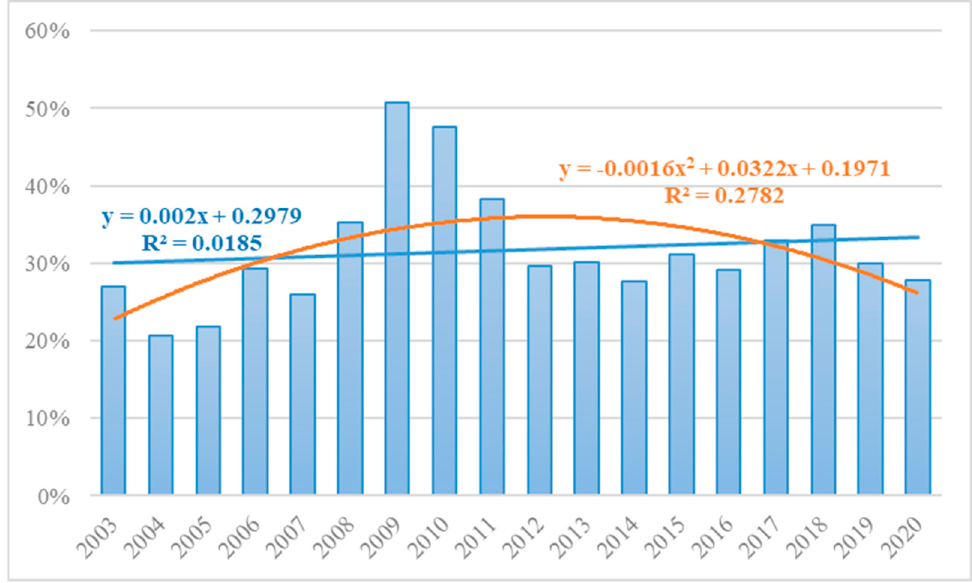
Figure 9. Ratio of liabilities to the annual budget revenues for 2003–2020 (in %) for the city of Ruda Ś l ą ska. Source: own elaboration.